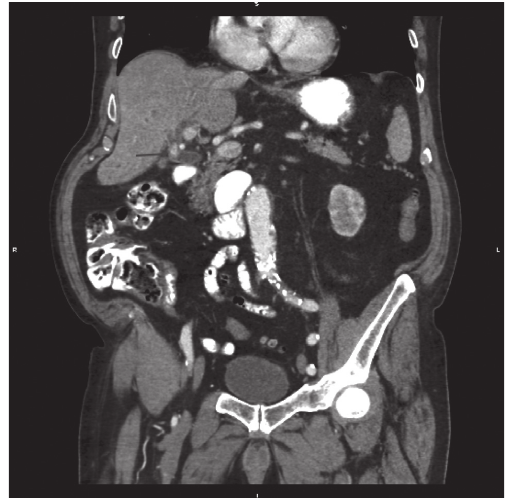
Figure 2: Coronal CTof the abdomen with contrast demonstrates 11 mm hyperdensity likely representing a calculus at the origin of the common bile duct (arrow).